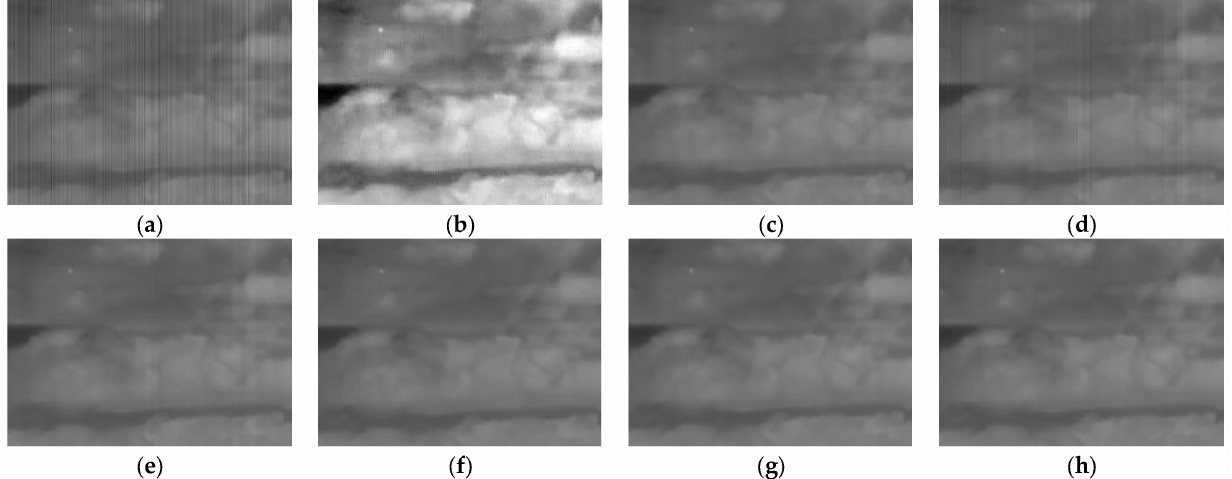
Figure 8. Comparison of methods using low-intensity nonuniformity infrared dim small target image: ( a ) infrared dim small target image with low-intensity nonuniform noise added; ( b ) MHE; ( c ) 1D-GF;